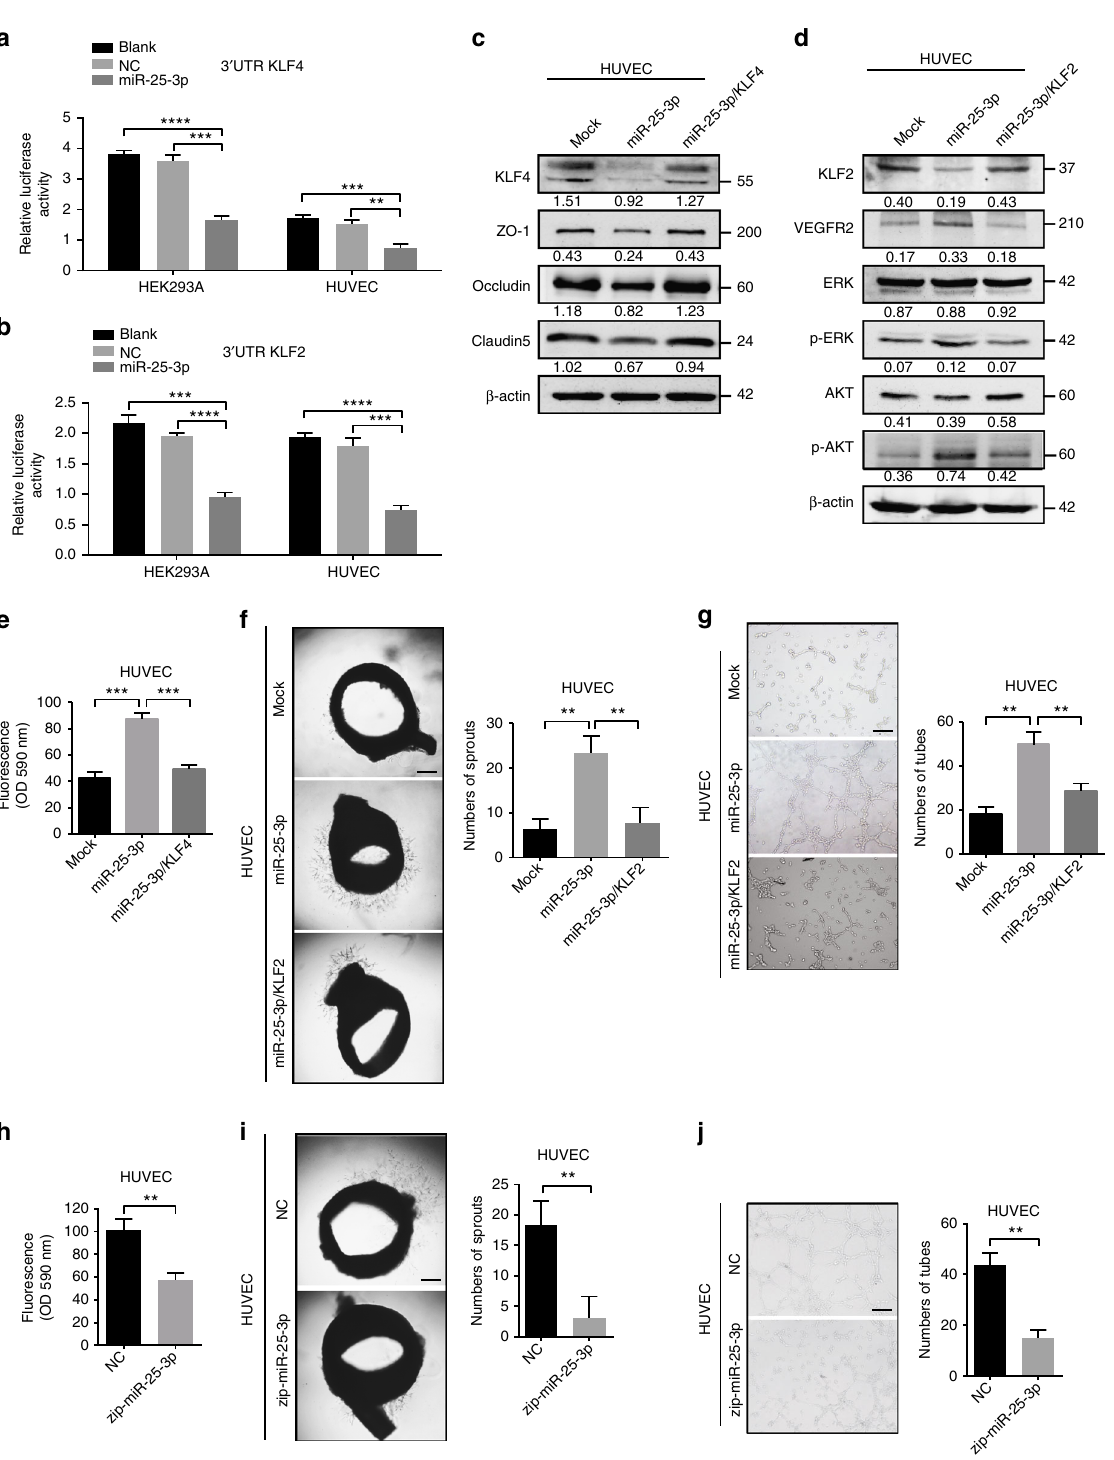
Fig. 3 KLF2 and KLF4 are functional targets of miR-25-3p in HUVECs. a , b Luciferase activities of 3 ’ UTR KLF2-luc and 3 ’ UTR KLF4-luc constructs in HEK293A, HUVECs after transfection of miR-25-3p mimics. Mean ± SEM are provided ( n = 3). c KLF4, ZO-1, occludin, Claudin5 expression in miR-25-3p overexpressing or miR-25-3p/KLF4 co-expressing HUVECs by western blot. d KLF2, VEGFR2, AKT, p-AKT, ERK, p-ERK expression in miR-25-3p overexpressing or miR-25-3p/KLF2 co-expressing HUVECs by western blot. e Effects of miR-25-3p and miR-25-3p/KLF4 on permeability of HUVEC monolayers by in vitro permeability assay. Mean ± SEM are provided ( n = 3). f Effects of miR-25-3p and miR-25-3p/KLF2 on vascular outgrowth of rat aortic rings. Scale bar represents 200 µ m. Mean± SEM are provided ( n = 3). g Effects of miR-25-3p and miR-25-3p/KLF2 on tube formation ability of HUVECs by tube formation assay. Scale bar represents 100 µ m. Mean ± SEM are provided ( n = 3). h Effect of miR-25-3p knockdown on permeability of HUVEC monolayers by in vitro permeability assay. i Effect of miR-25-3p knockdown on vascular outgrowth of rat aortic rings. Scale bar represents 200 µ m. Mean± SEM are provided ( n = 3). j Effect of miR-25-3p knockdown on tube formation ability of HUVECs by tube formation assay. Scale bar represents 100 µ m. Mean ± SEM are provided ( n = 3). ** P < 0.01, *** P < 0.001 according to two-tailed Student ’ s t